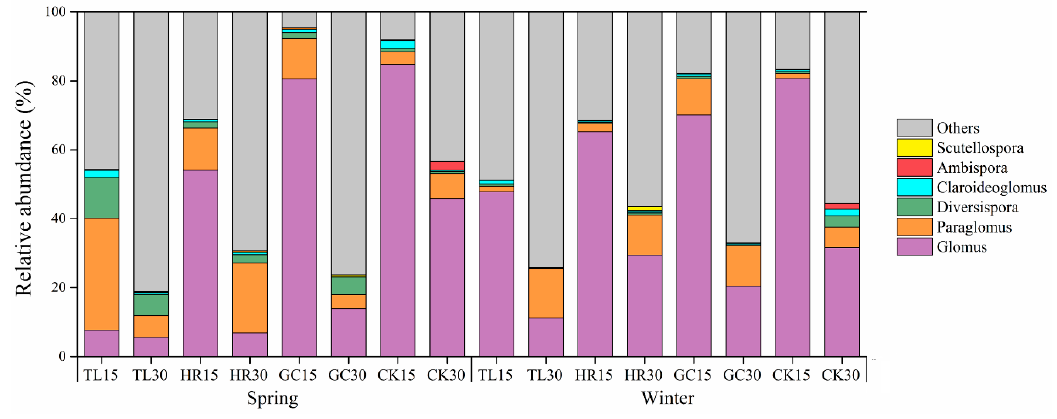
Figure 6. Relative abundances of AMF genera in all samples.